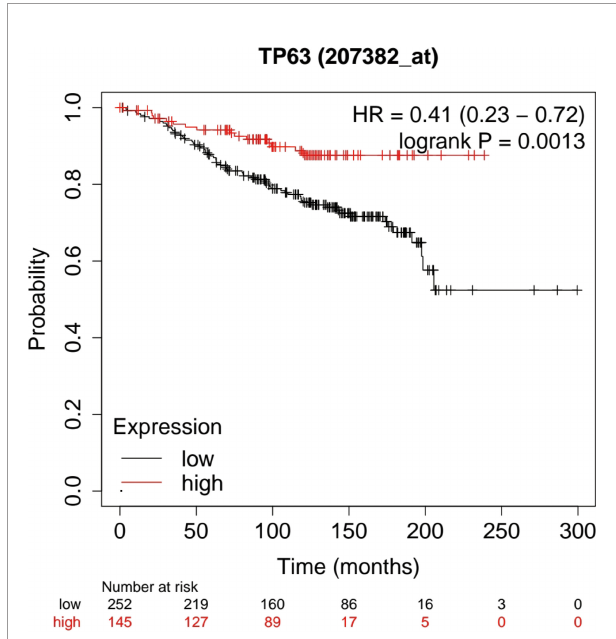
FIGURE 6 | Kaplan-Meier analysis was used to determine the prognostic role of TP63 in breast cancer. The prognostic potential of TP63 expression in breast cancer (p <